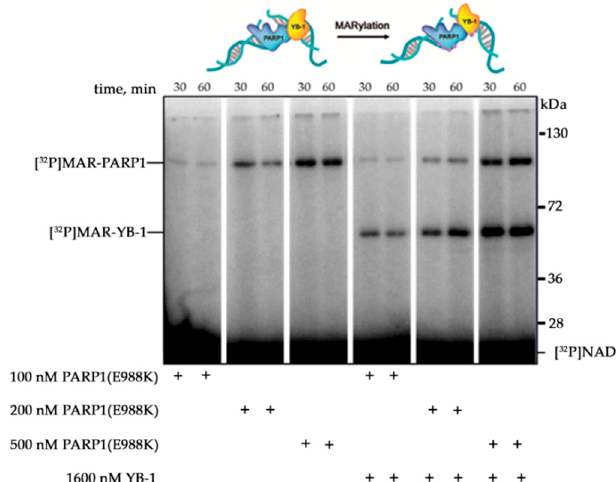
Figure 1. Y-box-binding protein 1 (YB-1) stimulates mono(ADP-ribosyl)ation (MARylation) activity of the poly(ADP-ribose) polymerase 1 (PARP1)(E988K) mutant. Evaluation of protein MARylation in the presence of [ 32 P]NAD and DNA duplexes containing a nick by SDS-polyacrylamide gel electrophoresis (PAGE) with subsequent phosphor imaging. The reaction mixtures contained 100–500 nM PARP1(E988K), 100 nM DNA substrate 4 µ M NAD + and [ 32 P]NAD + (0.4 µ Ci), and 1600 nM YB-1, as indicated.